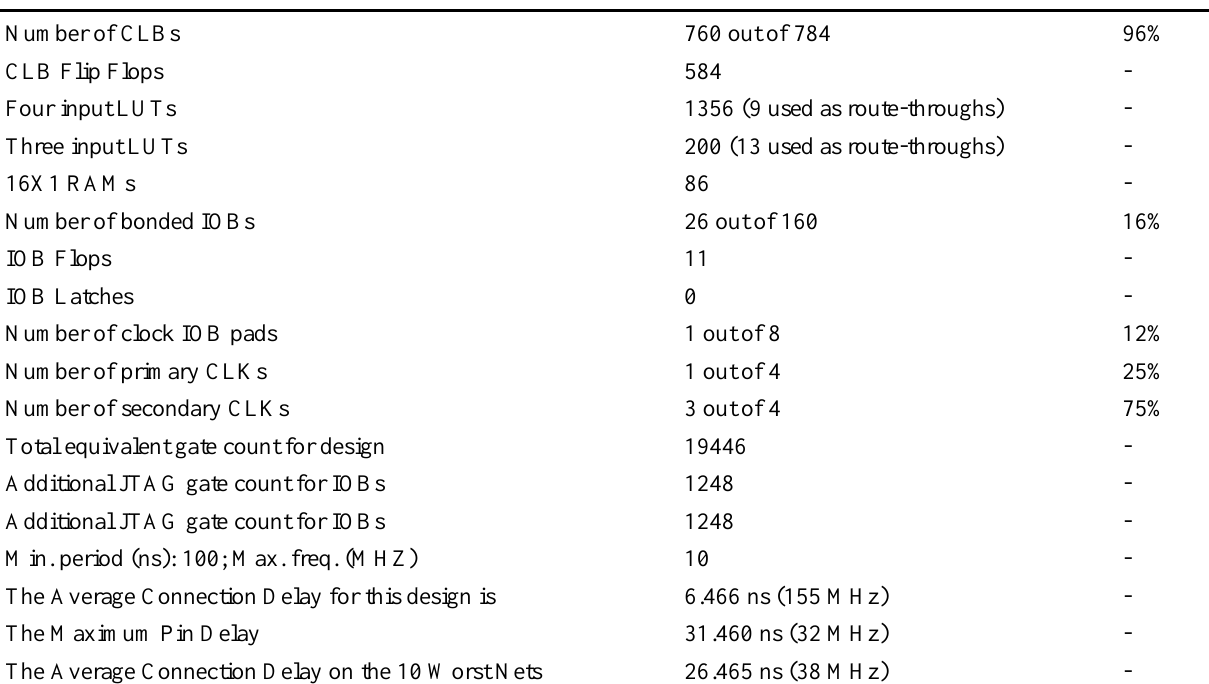
Table 7. Results of synthesis architecture.